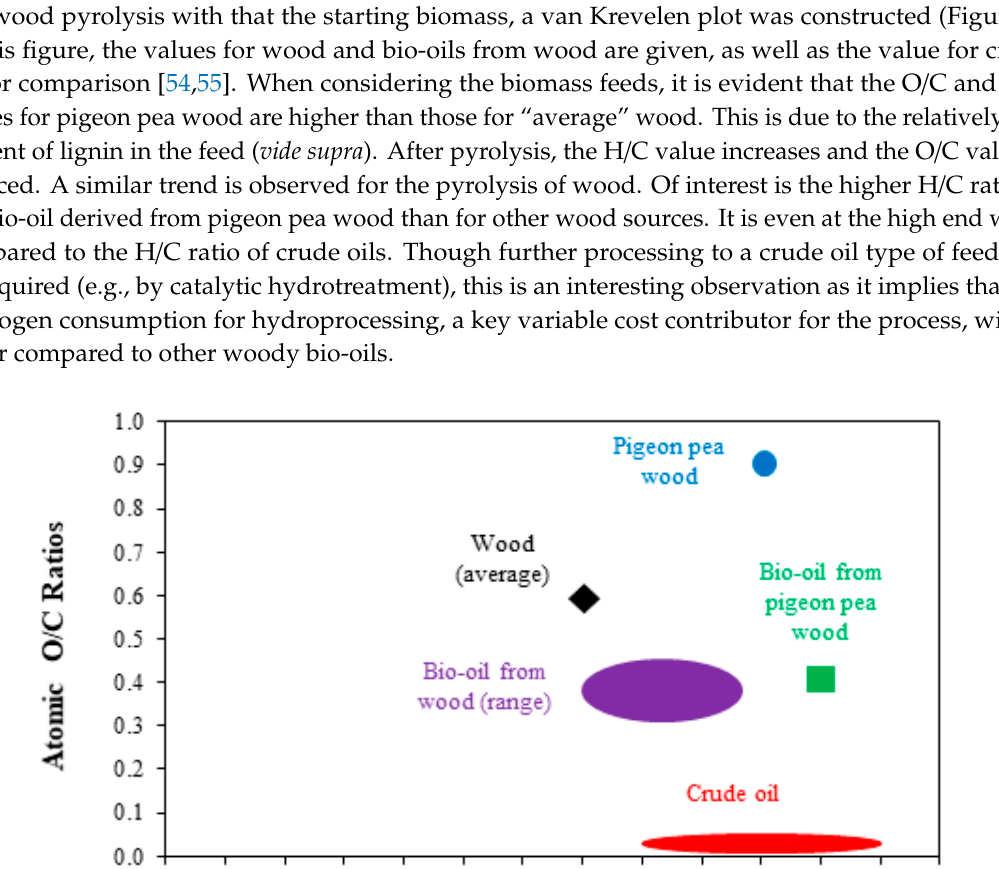
Table 5. GC detectables in the bio-oil obtained from pigeon pea wood pyrolysis at optimized conditions (semi-quantitative analysis by GC–MS). Functional Group / Compound Name